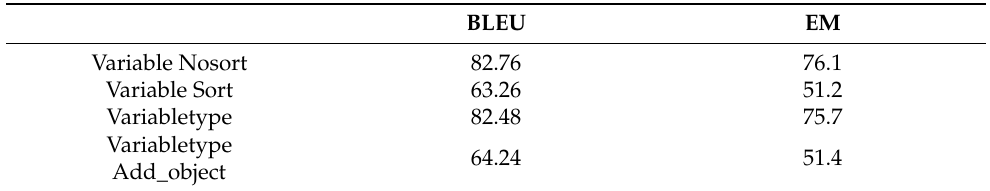
Table 7. BLEU and EM scores with code